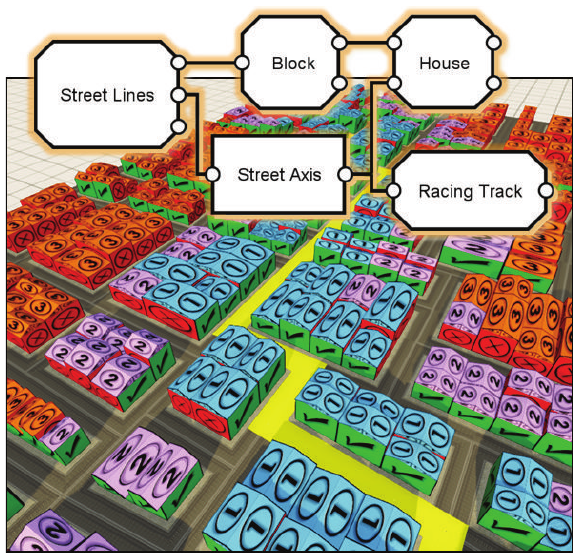
Figure 1: Our graph-based approach introduces context-awareness verifications which can be applied at any step of the generation process. Here, we perform visibility calculations to determine which fac¸ades are visible (marked in green) from a highlighted street (marked in yellow) and which are not (marked in red). We also calculate the minimum distance of each house towards that same streetanddecideonalevelofdetail(1,2,or3,asmarkedontheroofs) based on the distance. For applications focused on a main path, for example, racing games, this information could be used to guide the procedural content generation and include budget considerations in the construction of the virtual